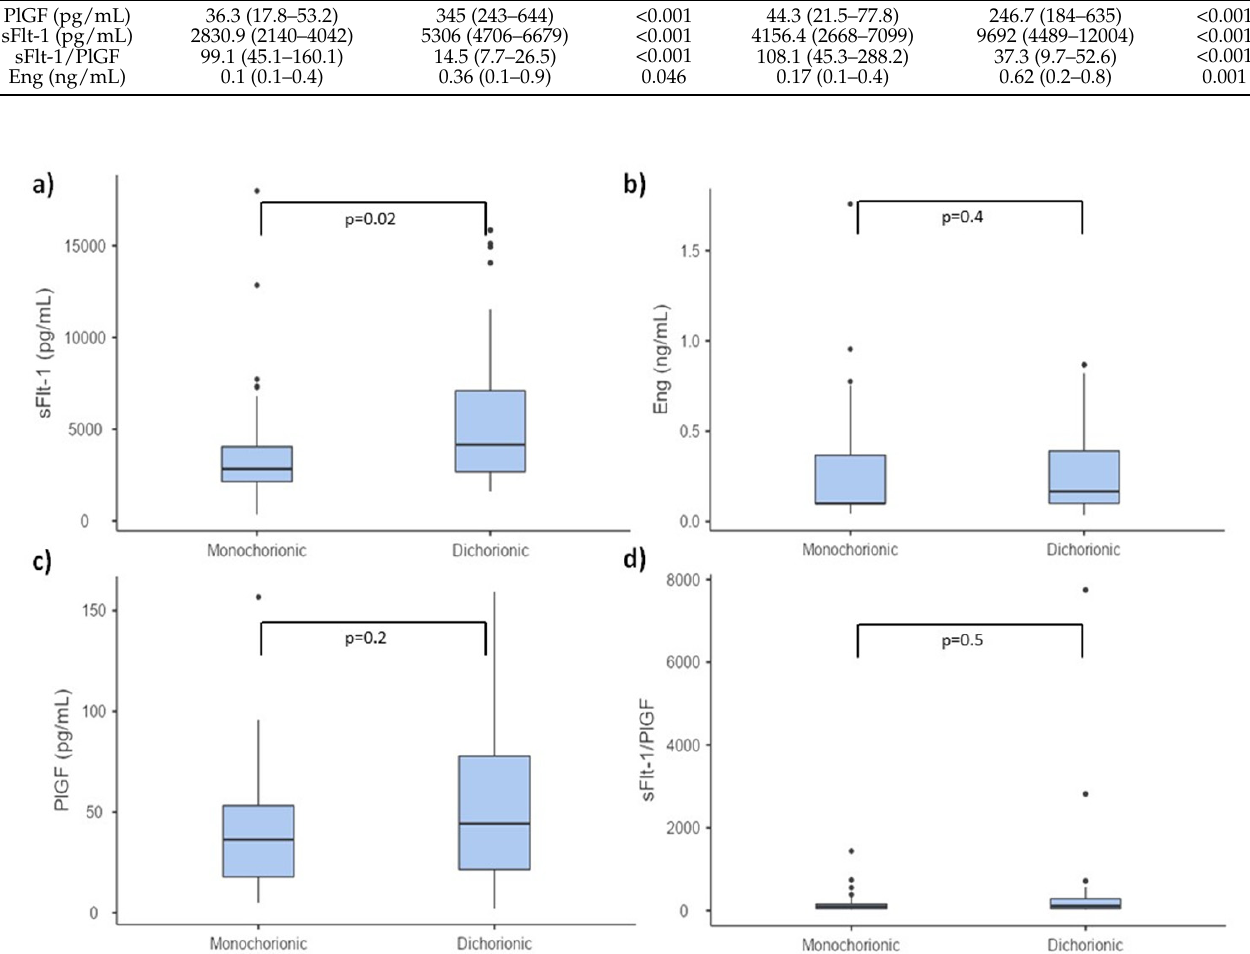
Figure 1. Box-and-whisker plots showing serum values of PlGF, sFlt-1, sFlt-1/PlGF ratio and sEng measured in the first trimester of twin pregnancy. ( a ) sFlt-1; ( b ) sEng; ( c ) PlGF; ( d ) sFlt-1/PlGF serum concentration. Serum concentrations of PlGF, sFlt-1, sFlt-1/PlGF ratio and sEng in the third trimester of pregnancy are presented in Table 3 and box-and-whisker plots showing biomarkers levels are presented in Figure 2. Similar to the results obtained in the first trimester, no significant differences in PlGF and sEng levels were observed between monochorionic and dichorionic groups. Analogously, sFlt-1 concentration was significantly higher in the dichorionic group. Due to the higher level of sFlt-1, the sFlt-1/PlGF ratio was also significantly higher in the dichorionic group. No significant differences were observed in serum concentrations of biomarkers depending on the smoking